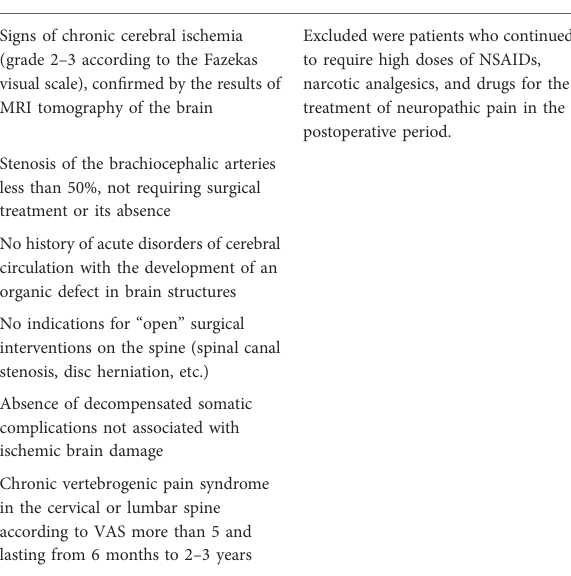
TABLE 1 Inclusion and exclusion criteria.